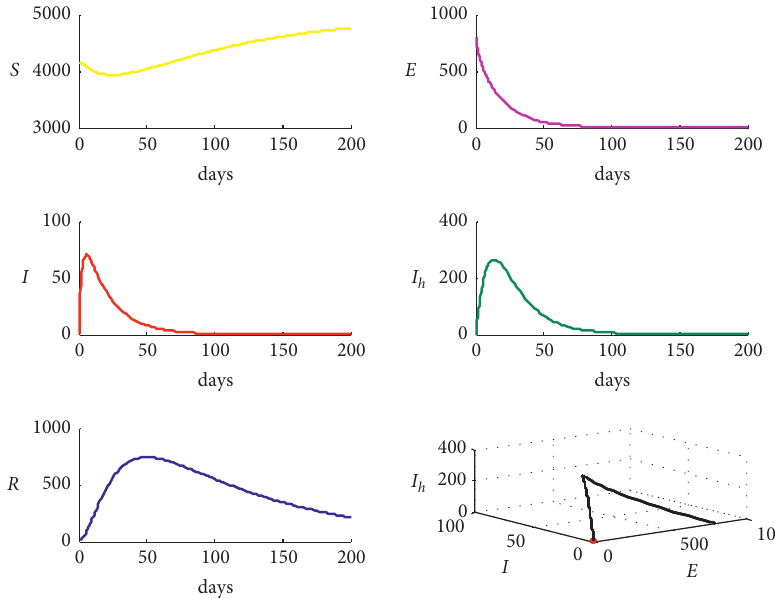
Figure 3: The trajectory of system (1) approaches to disease-free equilibrium